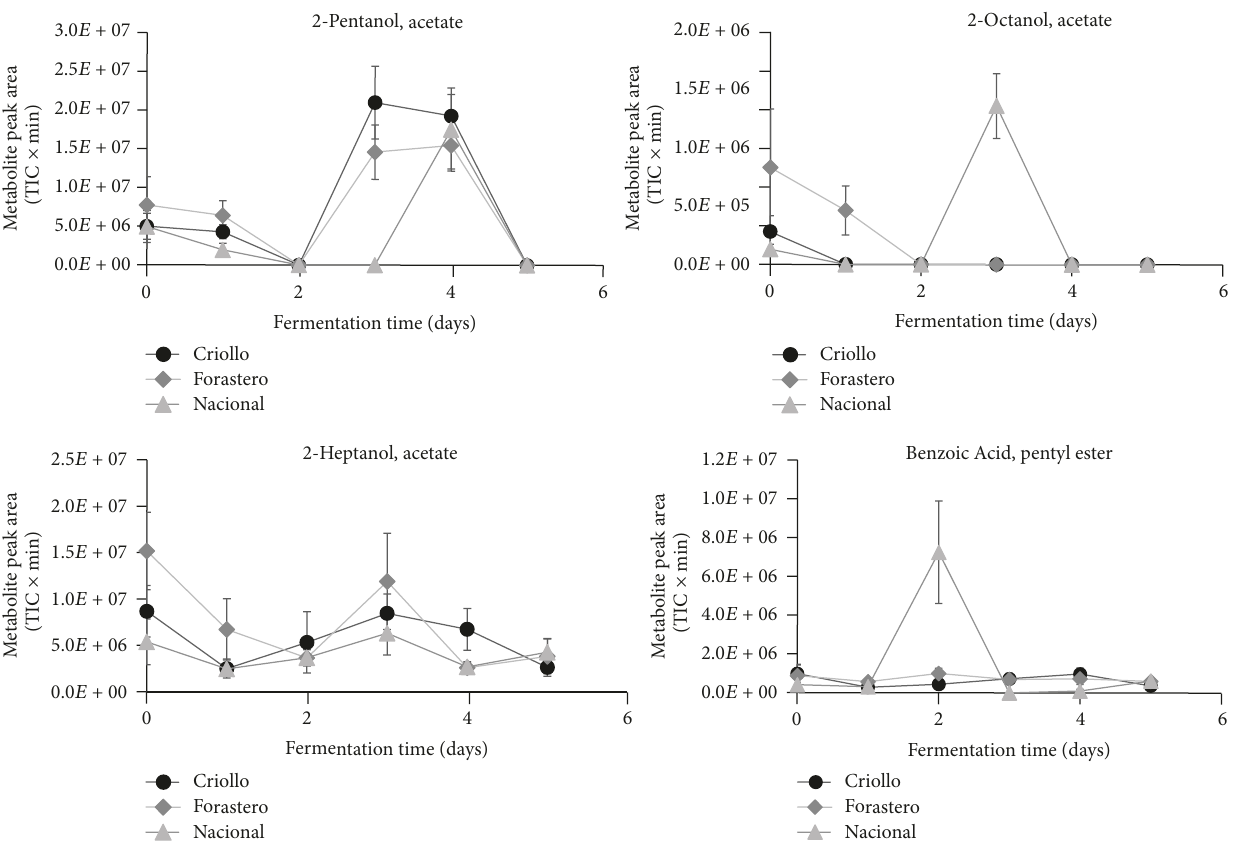
Figure 5: Levels of significant esters in Criollo, Nacional, and Forastero beans at different fermentation times. Levels of each metabolite are presented as peak area (total ion current times the differential retention time for each metabolite in